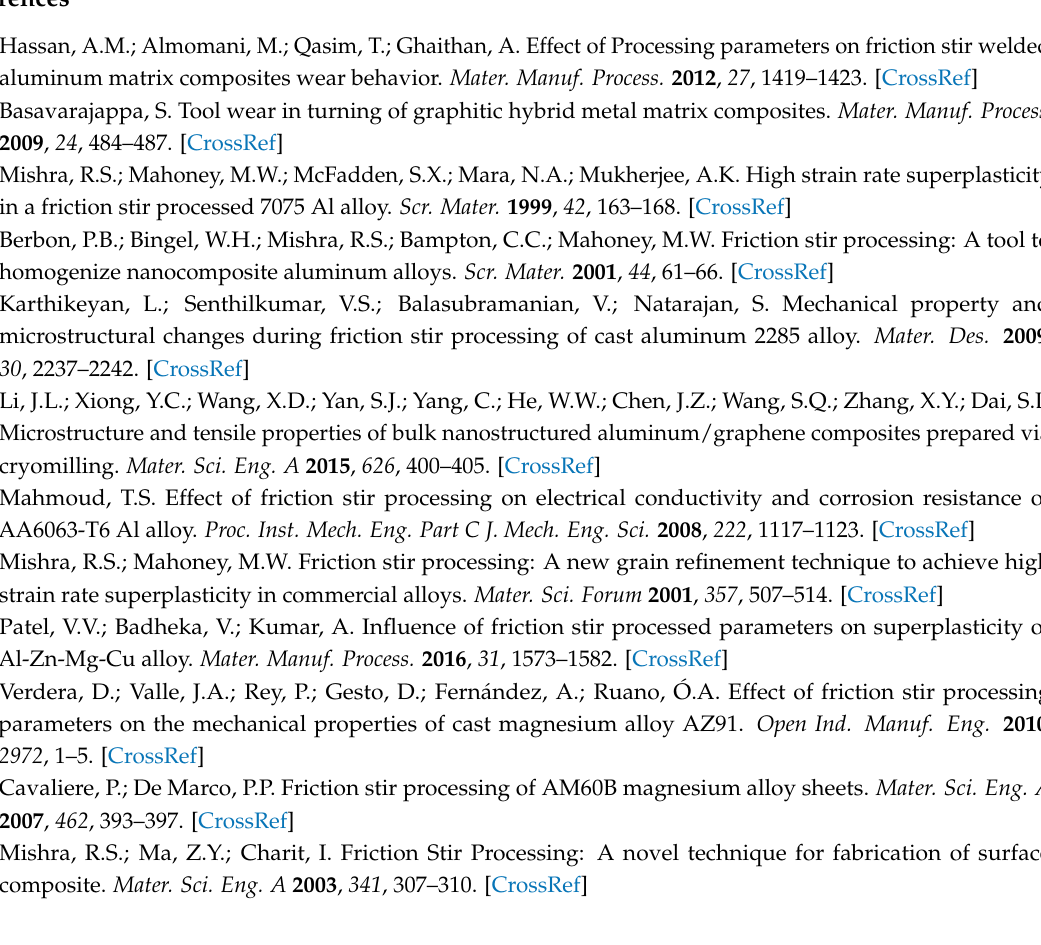
Figure S1: SEM micrograph of Al-SiC mono composite fabricated at 1800 rpm, Figure S2: SEM micrographs of various composite, Figure S3: Microhardness variation at cross-section with different reinforcements when processed at various processing